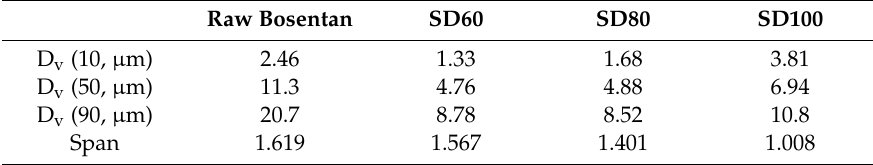
Table 2. Particle size and size distribution of raw material and spray-dried formulations.